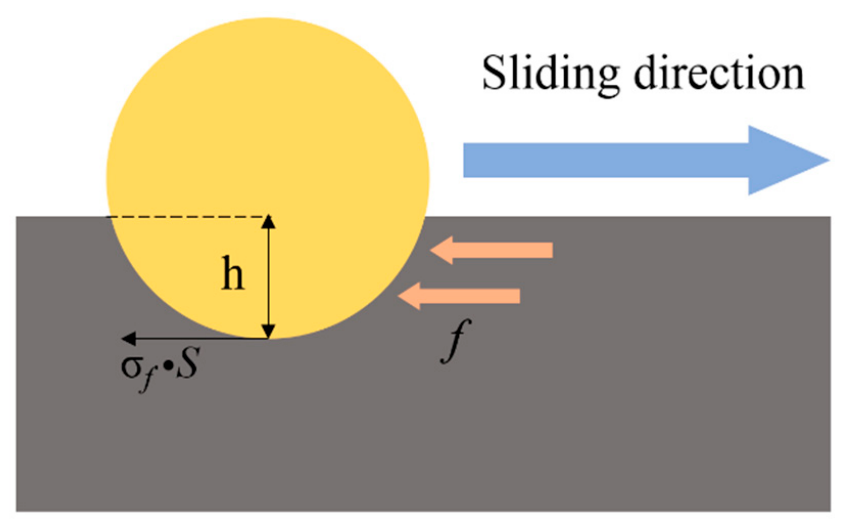
surface peeling and wear of the coating during the friction process, the COF will fluctuate, but the friction curve of the HF coating is the most stable. The wear volume of the 27SiMn steel substrate, the HF and GF coatings is shown in Figure 13. It can be noted that the HF coating has the lowest wear volume. The wear volume of the HF coating and the GF coat ‐ ing are 21.9% and 27.2% of the 27SiMn steel substrate, respectively, indicating that the wear resistance of the HF coating was better than that of the traditional GF coating. In the study of Kalyanasundaram et al. [35], they deposited diamond on the aluminum alloy substrate by electrodeposition technology. After conducting nanoindentation and wear experiments, they found that as the microhardness increases, the friction coefficient of the coating reduces from 0.60 to 0.32. Experience has proved that the microhardness of the coating is the main factor that determines the wear resistance, and the increase of the mi ‐ crohardness of the coating will increase the wear resistance.